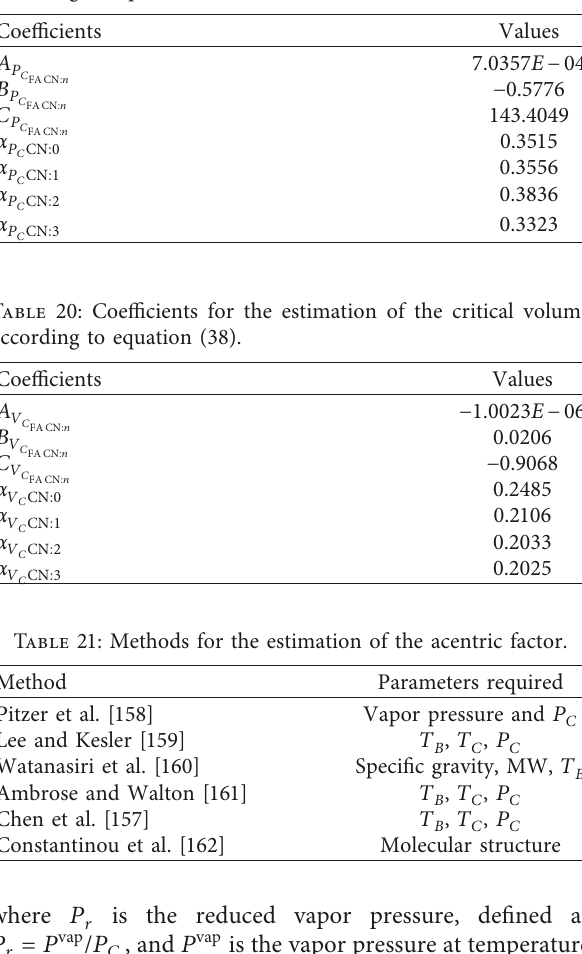
Table 18: Coefficients for the estimation of the critical temperature according to equation (36).